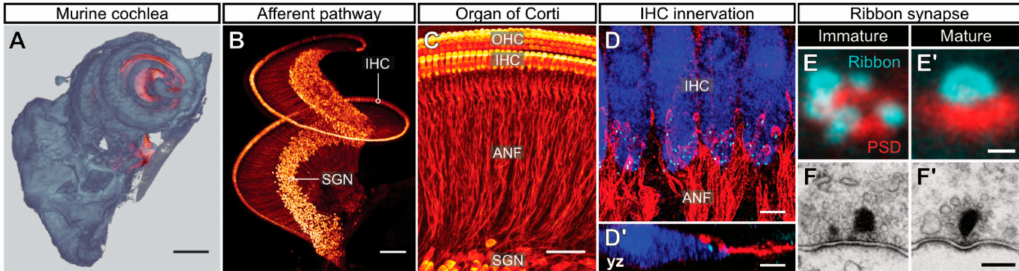
Figure 1. Structural overview of the peripheral auditory pathway. Light-sheet microscopic 3D- reconstructions of ( A ) the bony murine cochlea that harbors the organ of Corti and ( B ) the isolated peripheral auditory system, with a ff erent spiral ganglion neurons (SGNs) branching out towards the row of inner hair cells (IHCs), in the typical spiraling staircase anatomy. IHCs and SGNs are labeled with an antibody against the cytosolic Ca 2 + -bu ff er Calretinin. ( C ) Confocal maximum projection of the organ of Corti labeled for the cytosolic Ca 2 + -bu ff er Parvalbumin, displaying the three rows of outer hair cells (OHCs), the single row of IHCs and the a ff erent innervation (auditory nerve fibers; ANF) by the SGNs. ( D ) Innervation of IHCs (Calbindin; blue) by individual SGN neurites (a3-Na + / K + -ATPase; red), showing the presynaptic ribbons (CtBP2; cyan) in contact with the postsynaptic SGN boutons. ( D’ ) Side view of the innervated IHC showing the basolateral position of the synaptic ribbon and connected bouton. ( E , E’ ) STED microscopic images of IHC synaptic ultrastructure of ( E ) a developing IHC active zone distributed in several precursor spheres colocalizing with multiple clusters of the postsynaptic density (PSD) versus ( E’ ) one large ribbon opposing one ellipsoid PSD in a mature preparation. ( F , F’ ) Electron microscopic images of ( F ) immature multi-ribbon active zones with roundish profiles versus ( F’ ) the wedge-shape of a mature IHC ribbon that is attached to the curved presynaptic membrane. Scale bars: A 300 µ m; B 150 µ m; C 50 µ m; D-D’ 5 µ m; E-E’ 250 nm; F-F’ 200 nm. ( B , E , E’ ) with permission from Reference [4]; ( D ) with permission from Reference